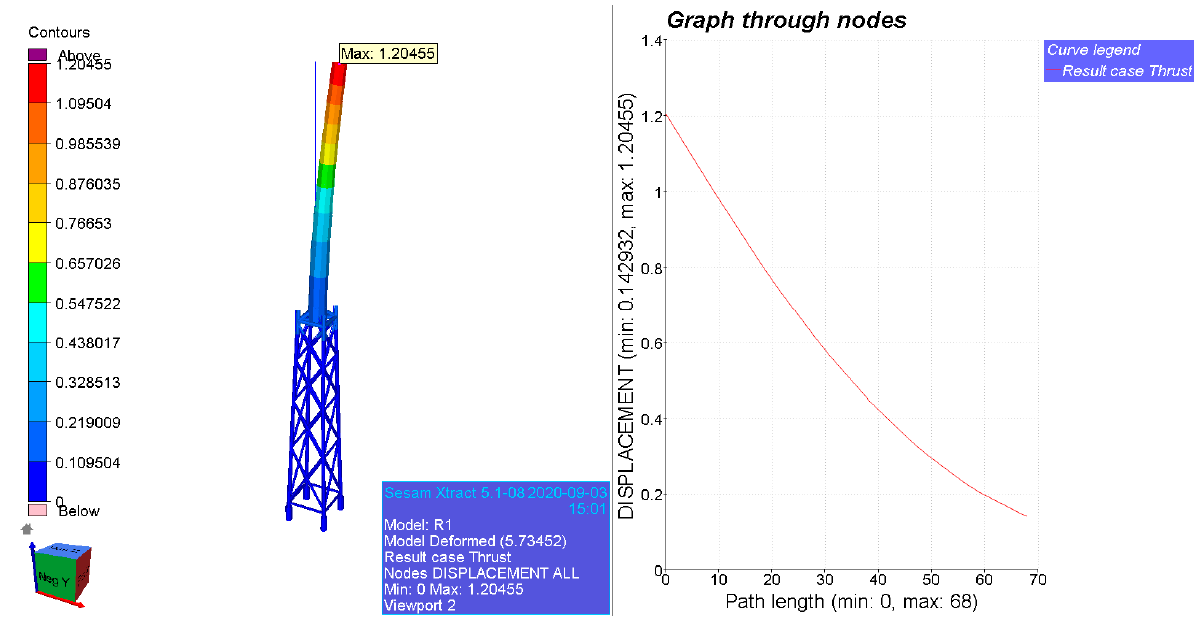
Figure 5. Deflection with a fixed base.